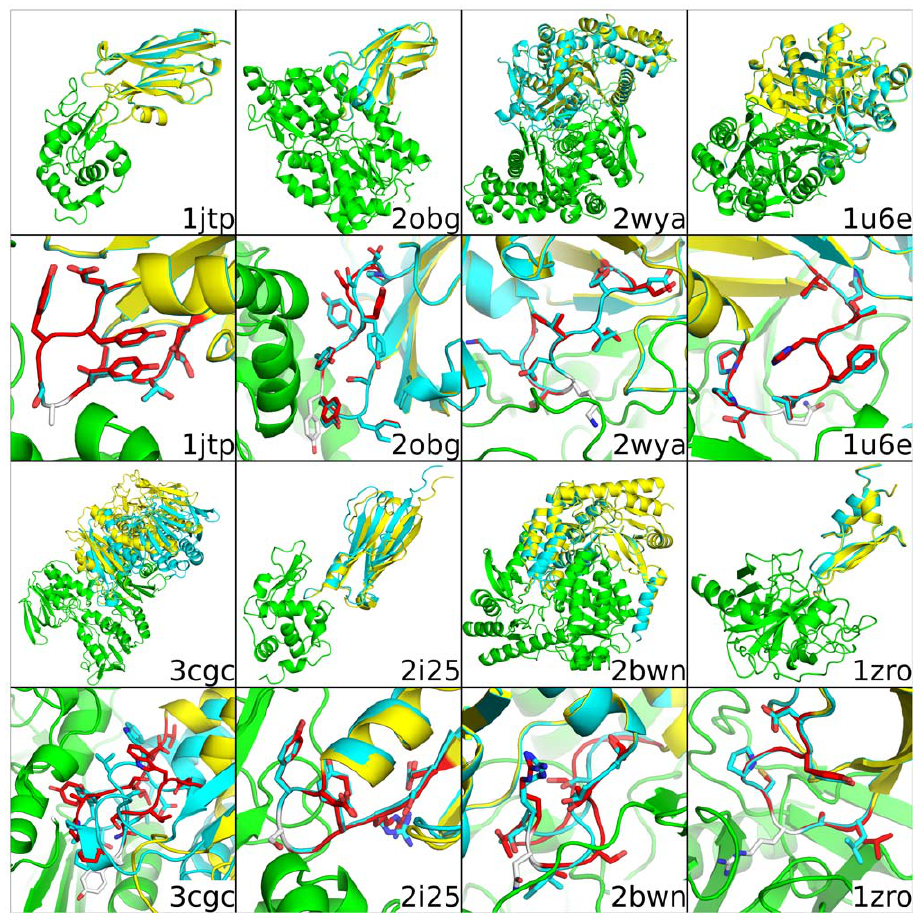
Figure 5. Best scoring prediction for 8 complexes. This figure demonstrates the relaxed crystal structure input and AnchoredDesign’s lowest- score prediction for 8 of the 16 structures. The first and third rows show whole structures, and the second and fourth zoom in on the predicted loops. The nonmoving side of the interface is in green, the actual partner in cyan and the prediction in yellow. The predicted loop is red and the anchor is white. Structures are labeled with their PDB code in the lower right of each cell. For most structures, the predicted rigid-body placement and loop is indistinguishable from the relaxed crystal structure; 3cgc (lower left) is the exception. The other 8 structures are shown similarly in Figure S2.